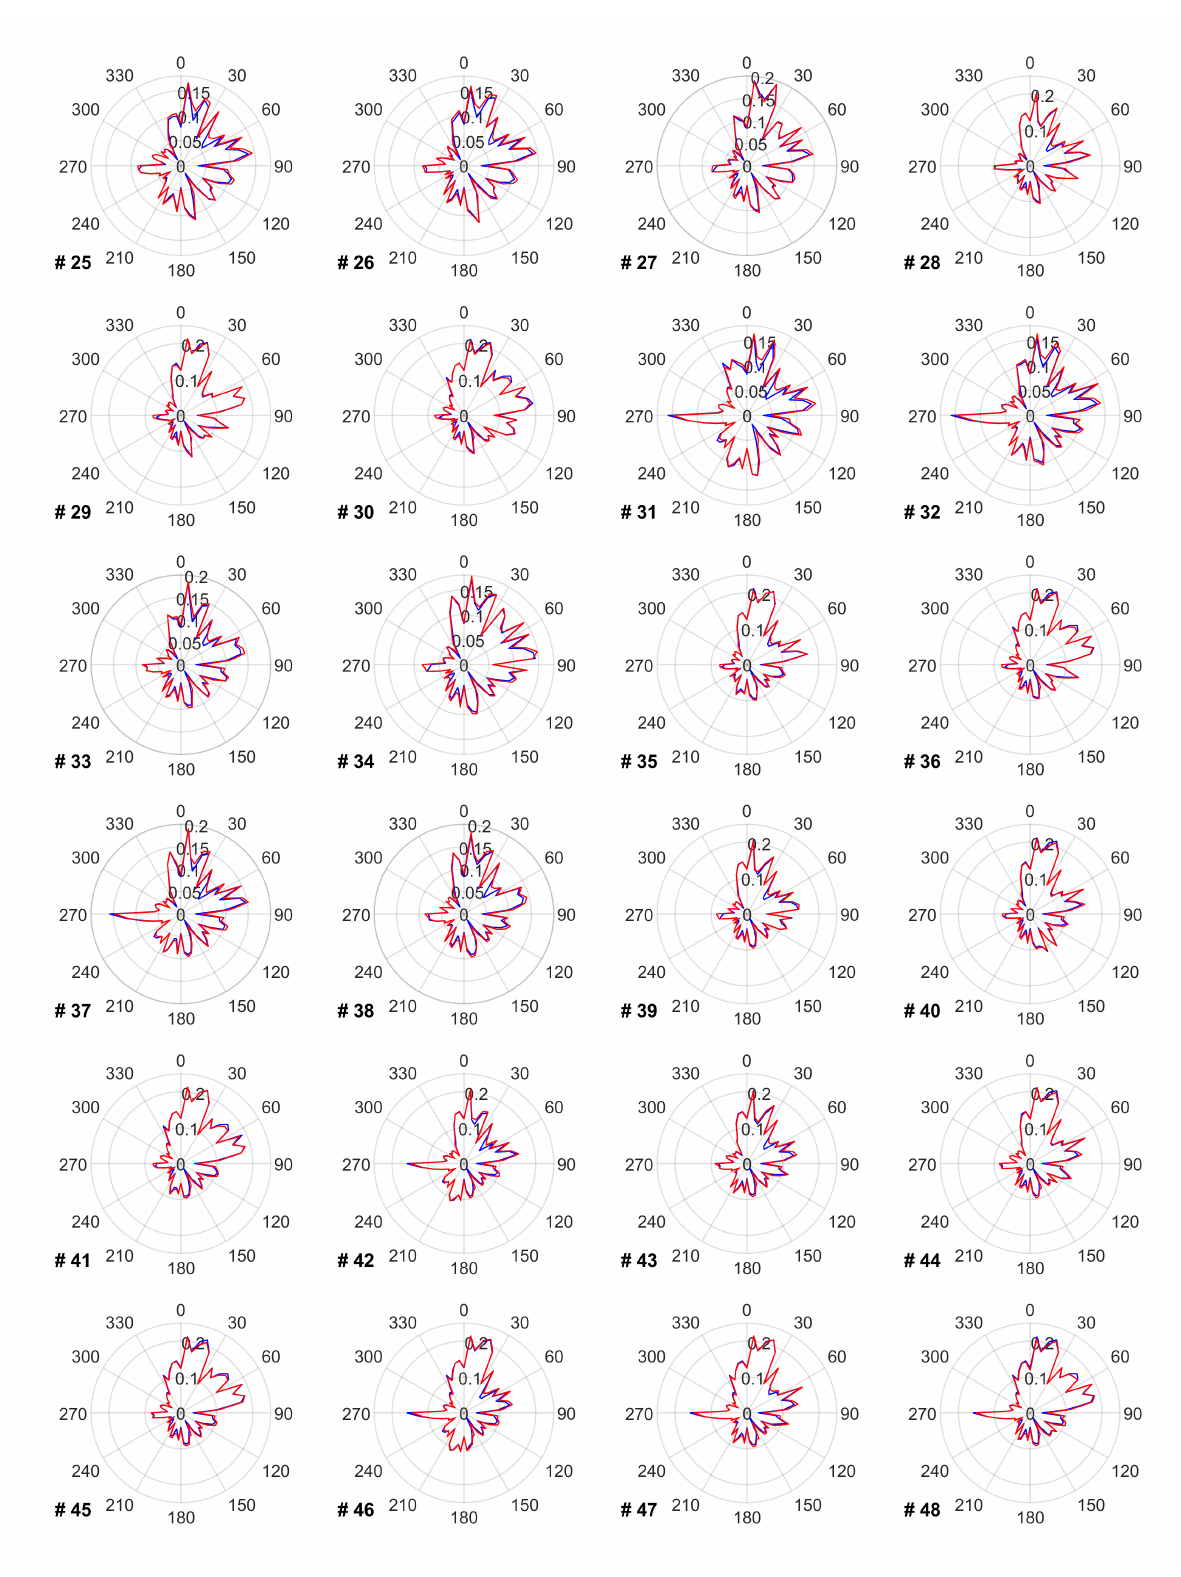
Figure A2. Blue line shows each turbine’s AEP in every wind direction in GWh without applying a TSR optimization. Red line shows the AEP after applying a TSR